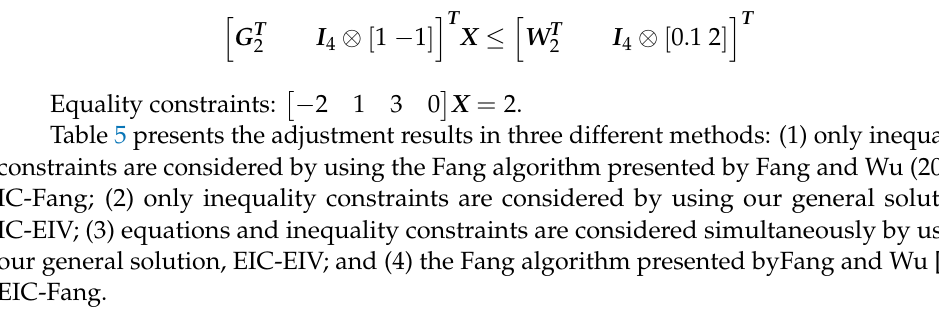
Table 5. Adjustment results of equality and inequality